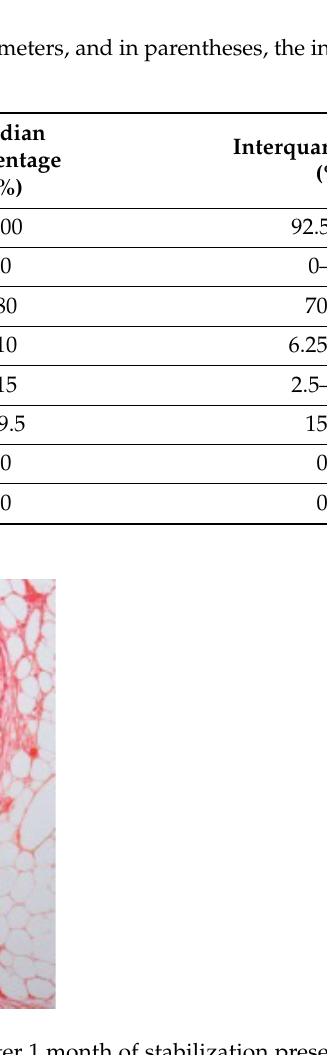
Figure 2. Patient ID: PD. Bone samples taken after 1 month of stabilization presented 70% woven bone (WB). The small black cross indicates the apical portion of the sample.